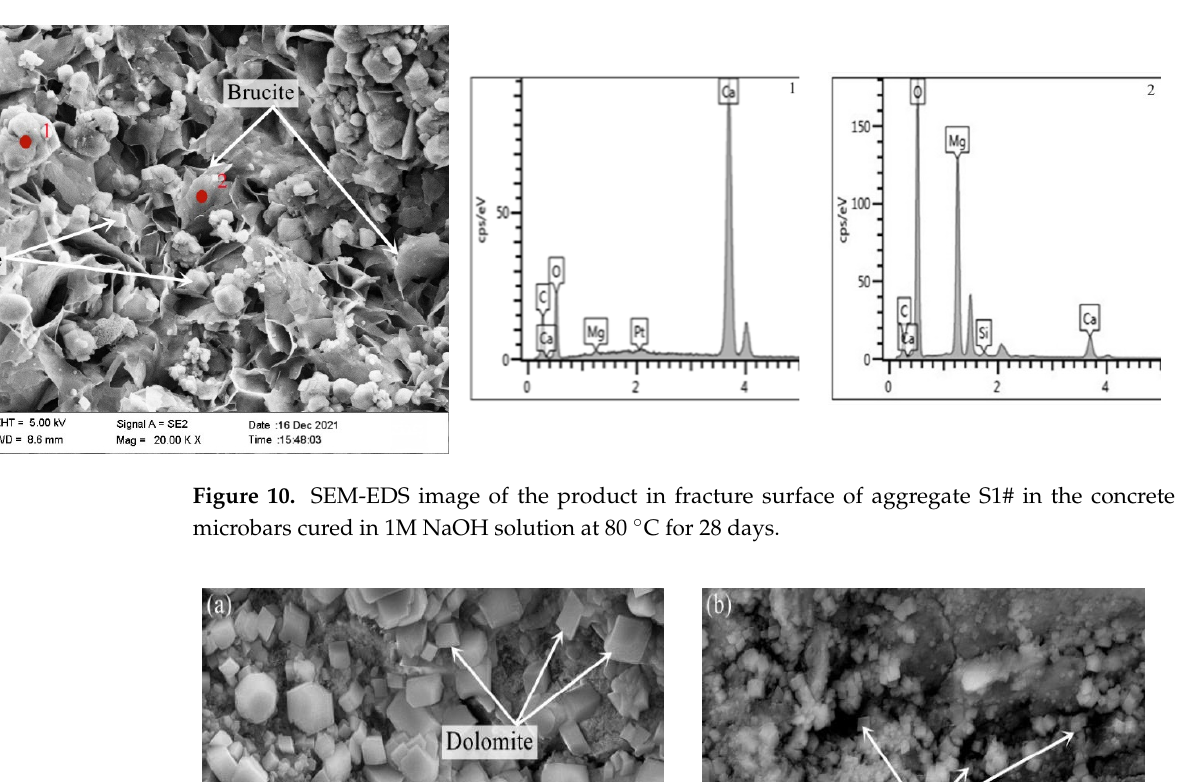
Figure 12. The expansion cracks of concrete microbars prepared with rock S1# cured in 1M NaOH solution at 80 ° C for 56 days. ( a ) control group; ( b ) 50% fly ash; ( c ) 50% metakaolin. 4. Conclusions The most significant conclusions of this paper are summarized as follows: (1) Four methods were used to determine that the dolomitic limestone S1# is alkali-car- bonate reactive aggregate. (2) In the concrete microbars test, metakaolin and fly ash can effectively inhibit the ACR of reactive aggregate, and the more the content of fly ash and metakaolin, the more efficient the effect of inhibition. Less fly ash cannot effectively inhibit the alkali – ag- gregate reaction of active aggregate. When the content of fly ash and metakaolin is the same, metakaolin is more effective than fly ash.